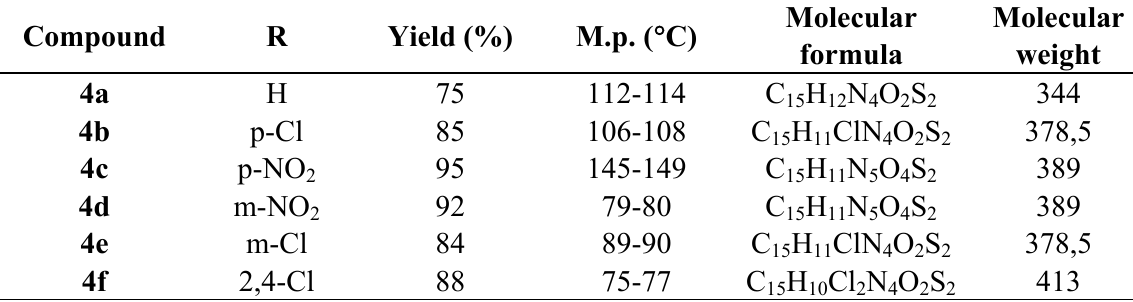
Table 1. Some properties of the compounds ( 4a-f